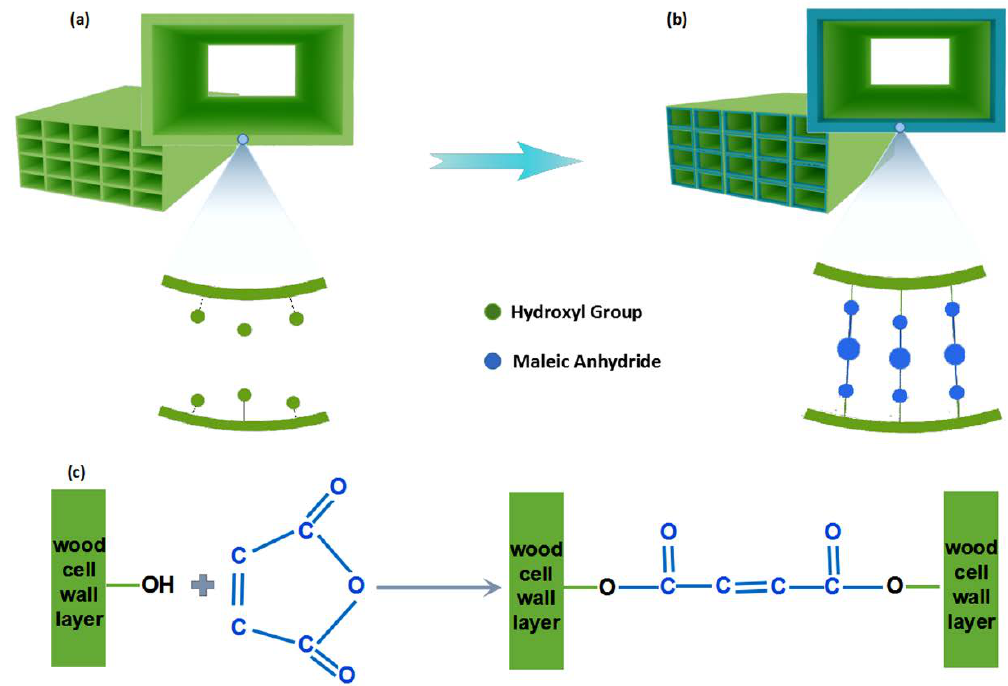
Figure 1. Schematic illustration of maleic anhydride (MAn) bulking and reacting with the wood cell wall ( a ) before and ( b ) after MAn bulking. ( c ) The scheme of the expected reaction mechanism of wood cell wall with MAn.